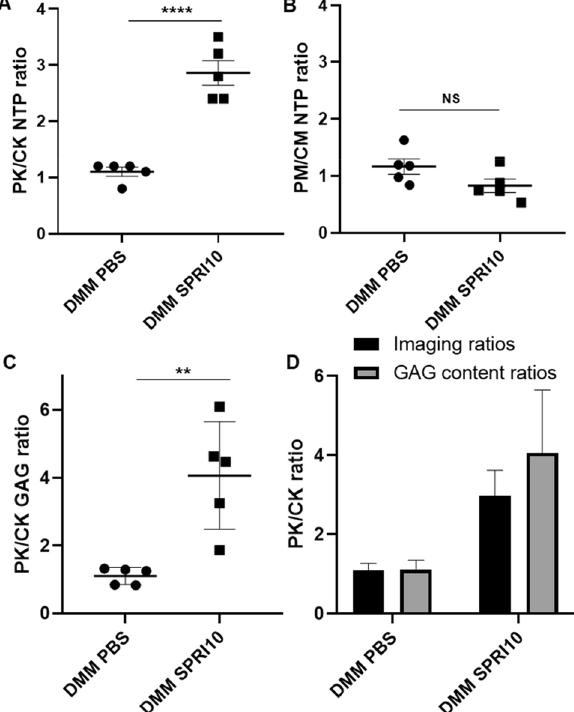
Figure 6. Sprifermin effect on imaging ratios and GAG content in DMM PBS and DMM SPRI10 at 5 W after surgery. ( A ) and ( B ): 99m Tc-NTP 15-5 ratios in knees (PK/CK ratio = uptake of pathological knee/uptake of contralateral knee) and muscles (PM/CM ratio = uptake in pathological leg muscle/uptake of contralateral leg muscle). ( C ) whole knee glycosaminoglycans content PK/CK ratios. ( D ) Correlation data summary. Results are mean ± SEM. DMM SPRI10 versus DMM PBS, ****p < 0.0001, **p < 0.01, NS: